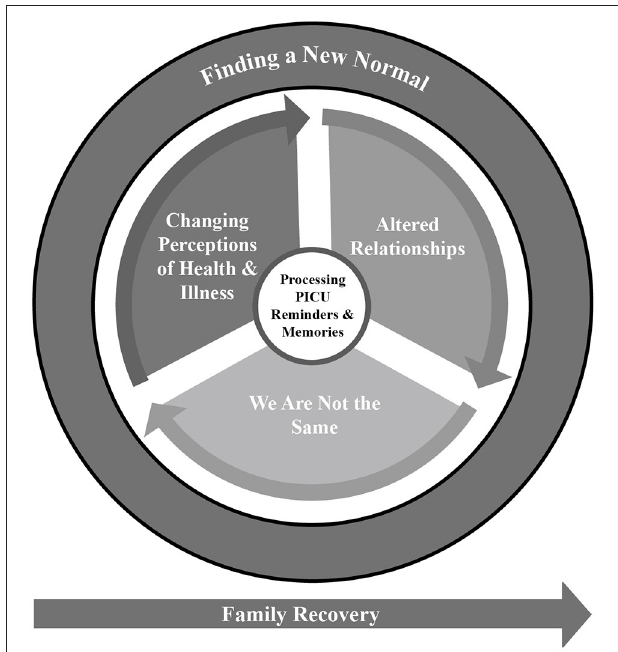
FIGURE 1 | Establishing family normalcy following PICU